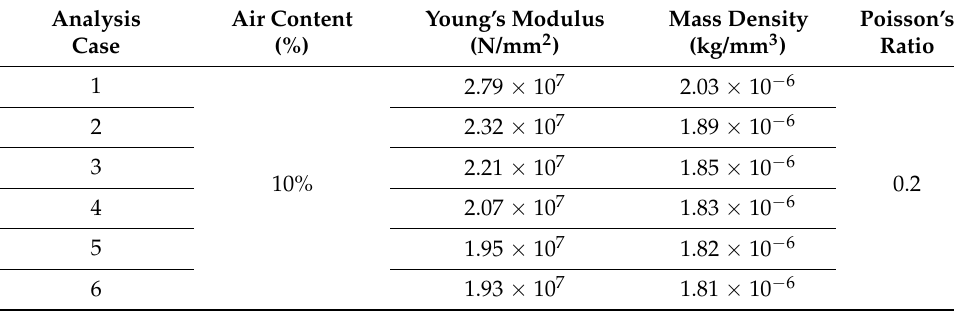
Table 2. Parameters used in the simulation.